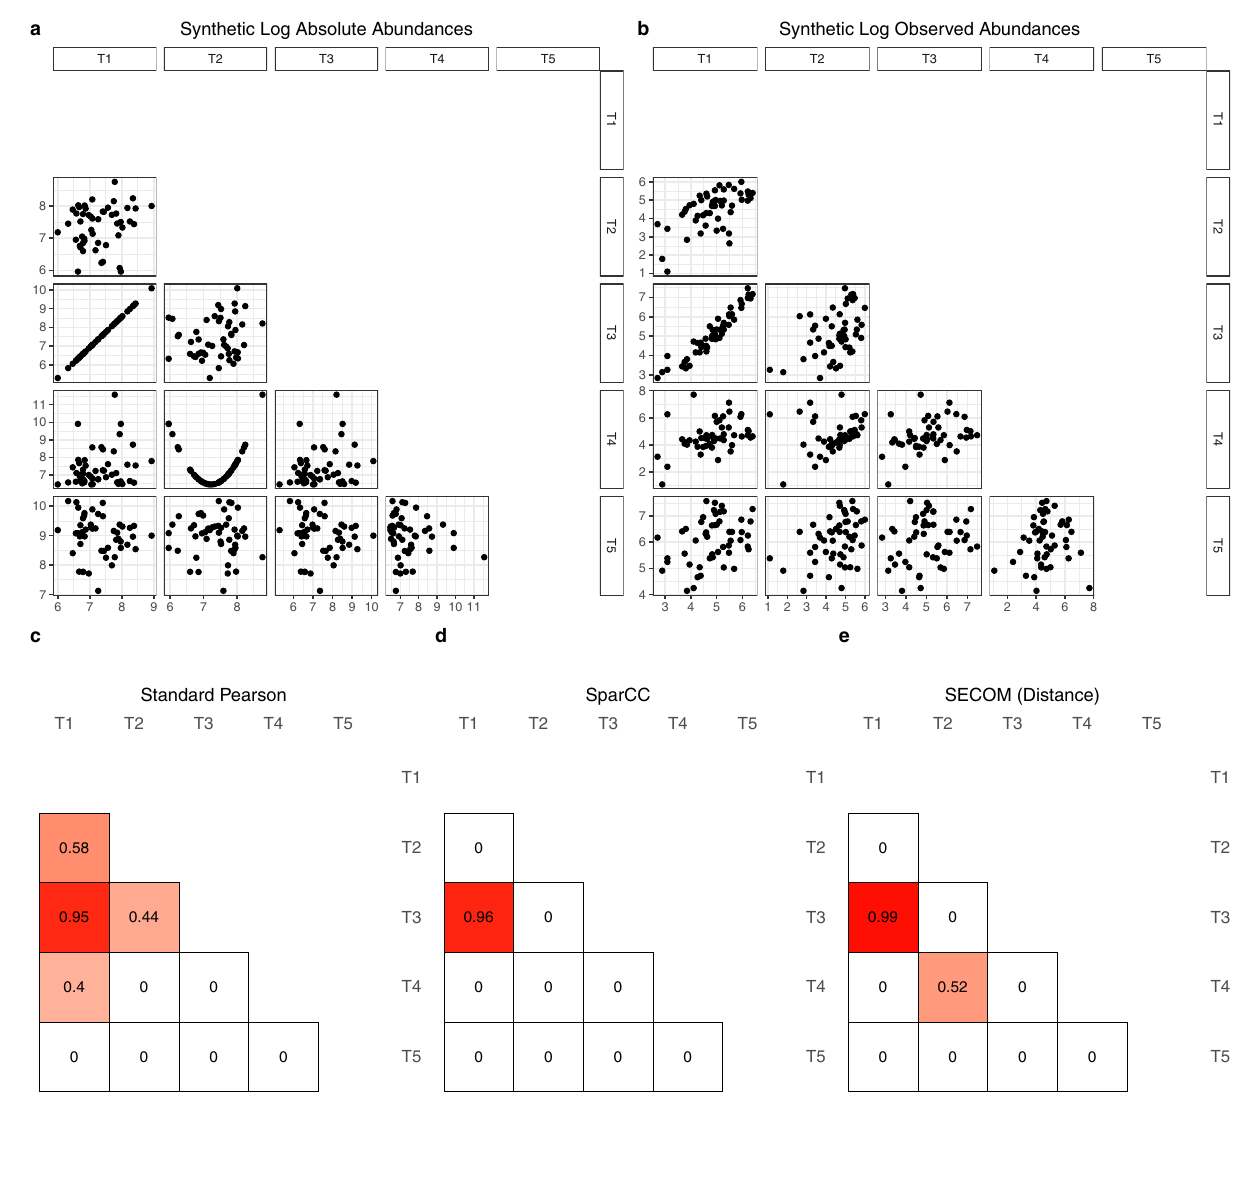
Fig.1|Atoyexampleshowingthedifferencesbetweencorrelationmethods. All scatter plots and correlations provided in the fi gure are based on log abundances. a A total of 100 taxa were generated, where the true abundances in the ecosystem weregeneratedusinglog-normaldistributions.TaxaT1andT3areperfectlylinearly correlated on a log scale, and taxa T2 and T4 are quadratically related. The remainingtaxaareuncorrelated.Onlythe fi rst5taxa(T1toT5)areprovidedforthe simplicity of exposition. Pairwise scatter plots of log abundances are provided in the lower triangle of the matrix. b Observed abundances were generated by incorporating sample-speci fi c sampling fractions and taxon-speci fi c sequencing